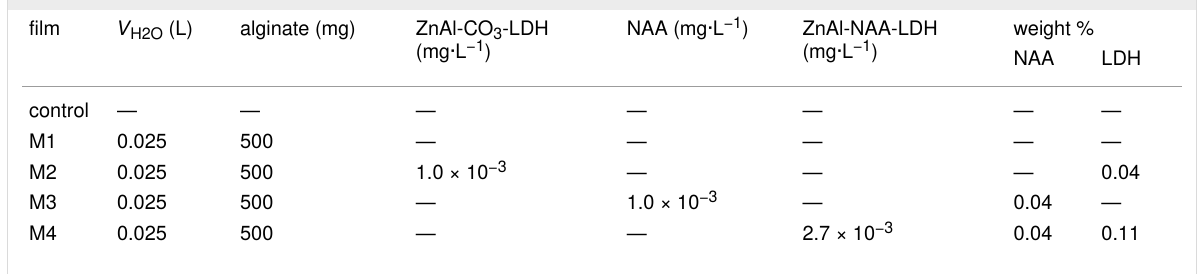
Table 1: Composition of polymeric alginate films. film V H2O (L)